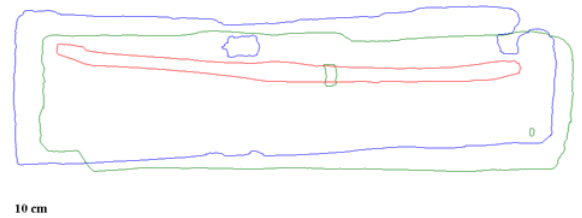
Figure 6. The comparison of the crossbar and the wooden boards of the archaeological find